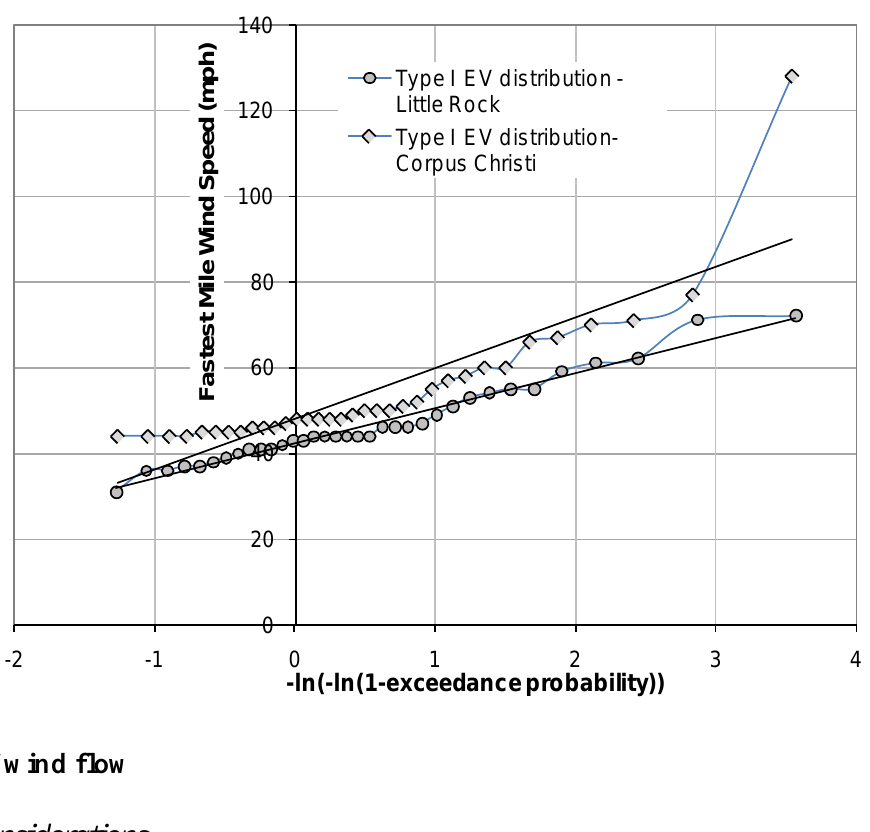
Figure 18. Extreme Value Distributions for two sample cases (Little Rock and Corpus